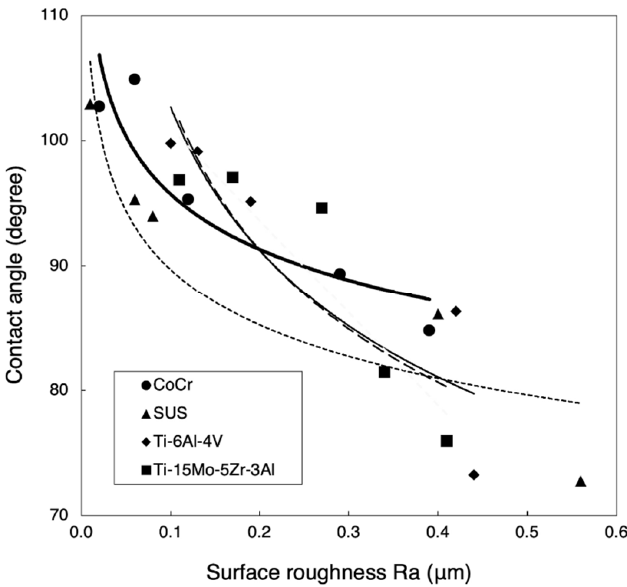
Figure 6. Relationship between the contact angle and surface roughness. The bold line, the dotted line, the solid line, and the dashed line indicate the power approximation fitted curve for CoCr, SUS, Ti-6Al-4V, and Ti-15Mo-5Zr-3Al.